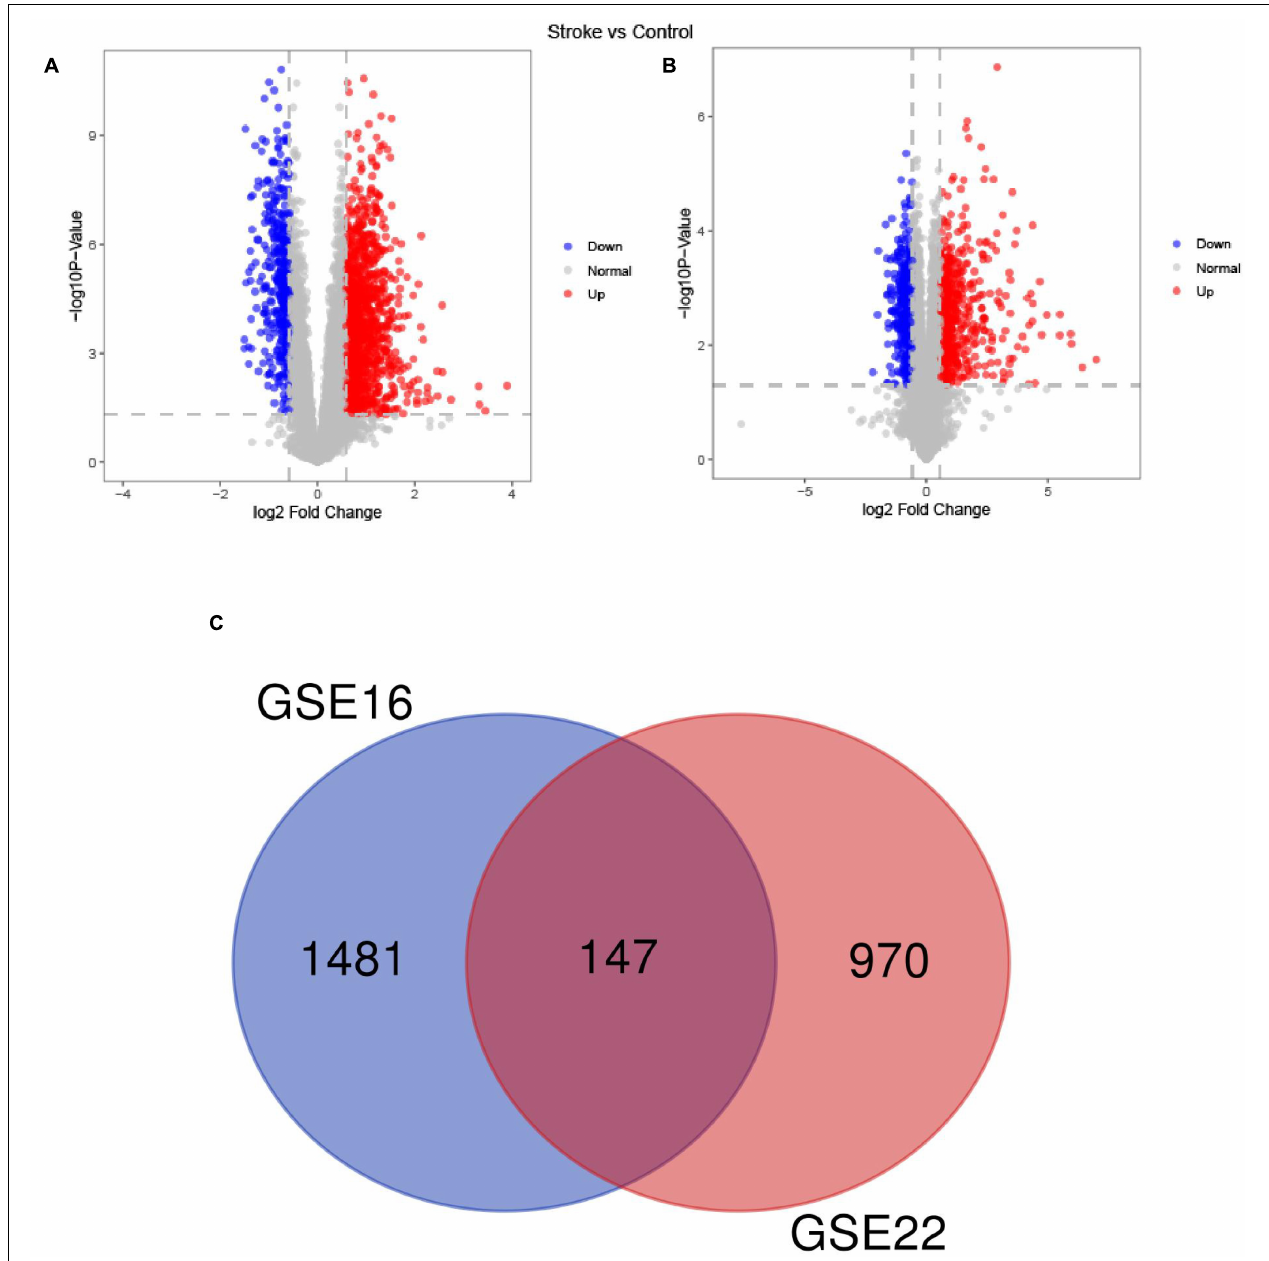
FIGURE 2 | A Venn diagram of the up- and down-regulated DEGs in the GSE16561 (A) and GSE22255 (B) datasets and the Venn diagram depicts DEGs shared by the GSE16561 and GSE22255 series of samples (C)